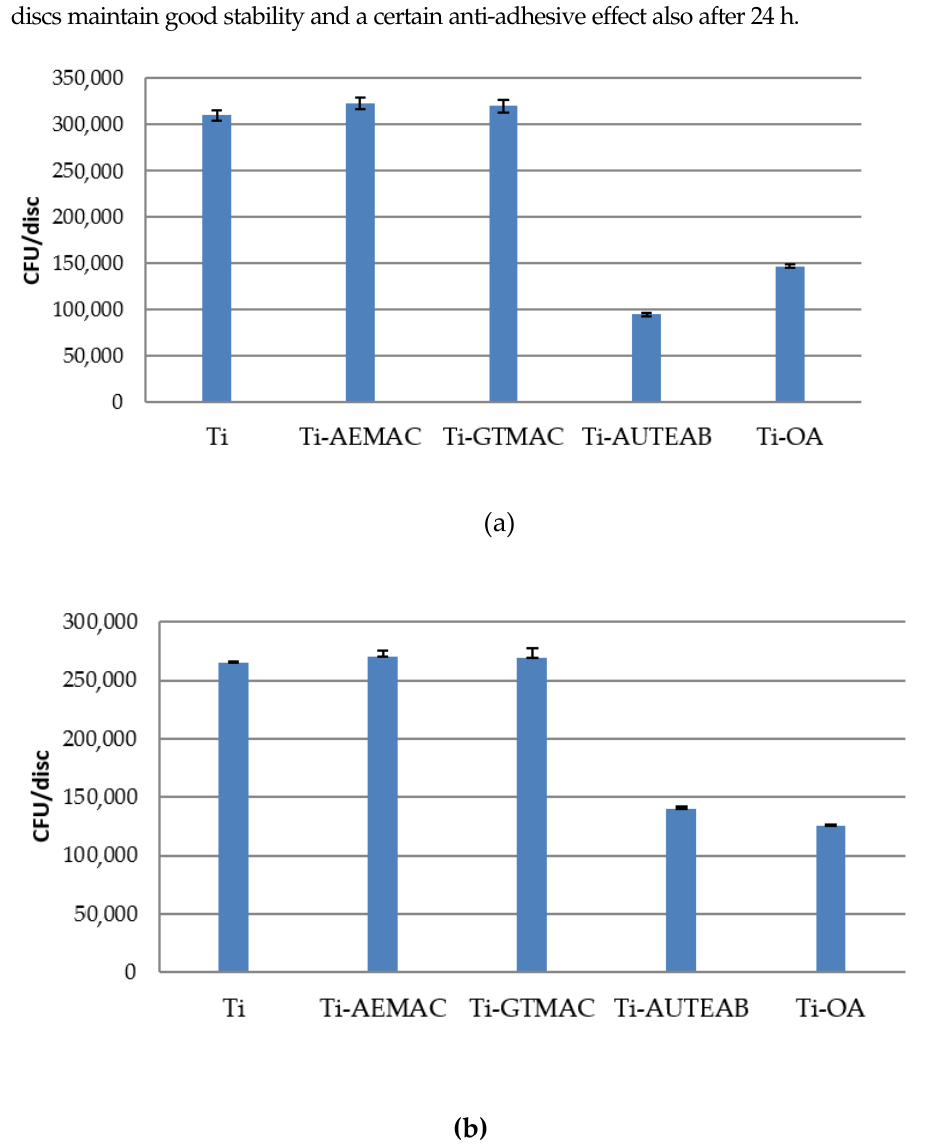
Figure 11. (a ) Number of E. coli ( a ) and of ( b ) S. aureus adhered after 1.5 h of bacterial contact on bare titanium discs (Ti) and on the functionalized samples Ti-AEMAC, Ti GTMAC, Ti-AUTEAB, and Ti-OA P; Error bars indicate standard deviation (SD) from three independent CFU counting (i.e., n = 6). “Elaboration standard deviation with ANOVA, p < 0.0001 ”. The improved antimicrobial behavior of these samples can be rationalized considering their less hydrophilic behavior with respect to the other samples and on the basis of the chemical nature of the inserted organic moieties. Both samples possess a long alkyl chain (C 11 for Ti-AUTEAB and C 16 for Ti-OA) between the silicon atom and the ammonium functionality which, as also reported in studies on other cationic salts, is an important factor able to significantly increase the antibacterial activity.